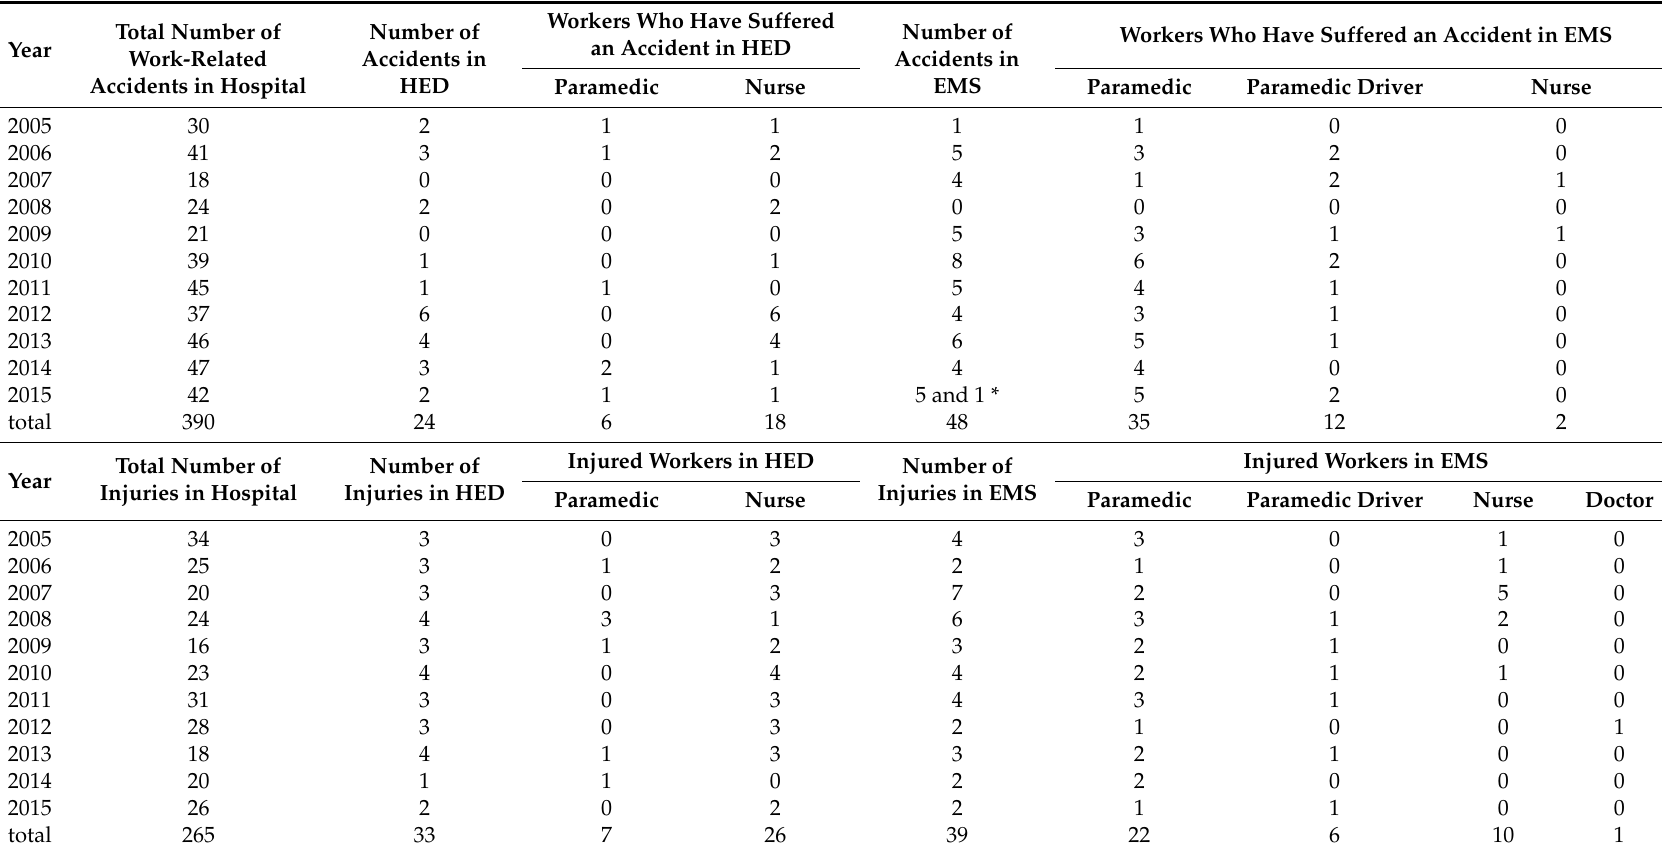
Table 1. Total number of work-related accidents and sharp injuries in the hospital and in paramedics employed in selected wards, in